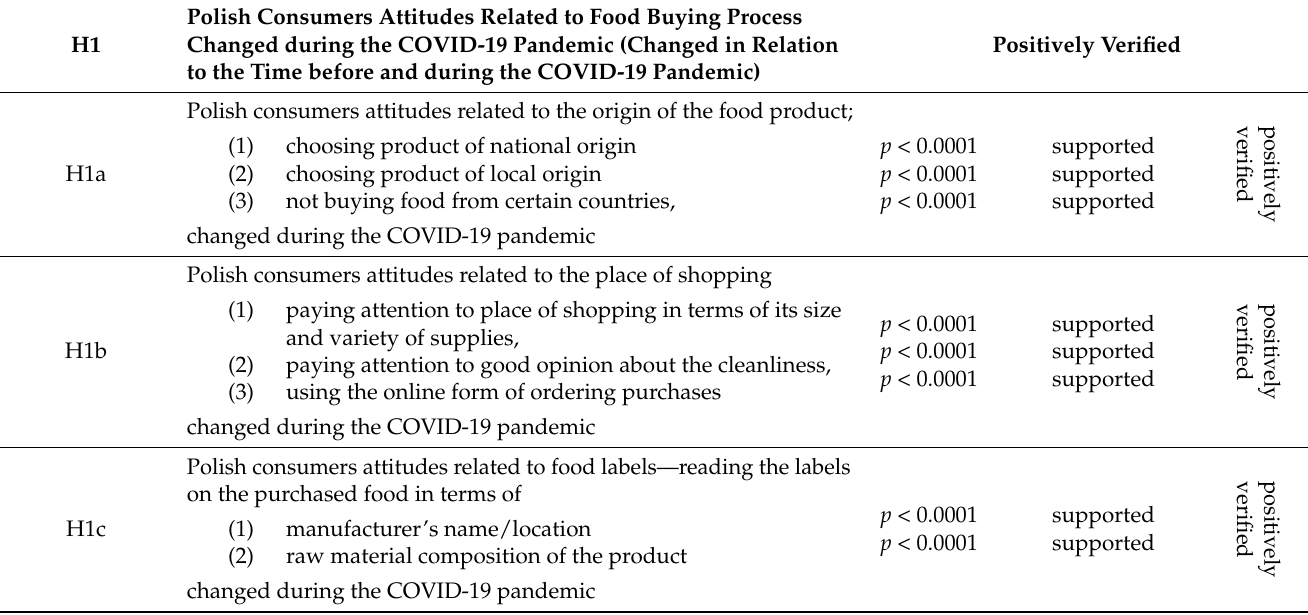
Table 11. Verification of the Hypothesis